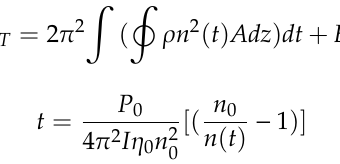
Figure 2. Schematic diagram of the main structural parameters of the impeller.